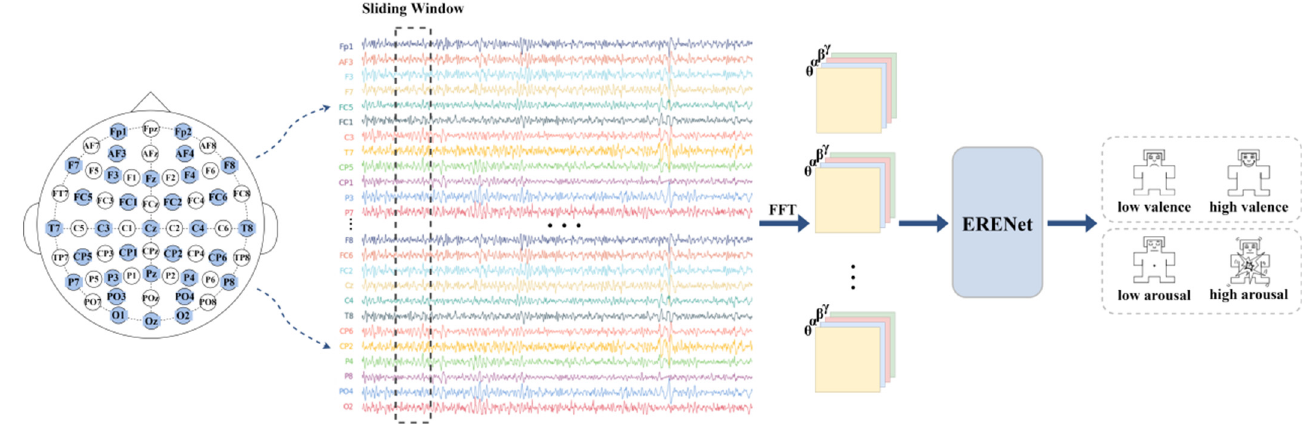
Figure 1. The emotion recognition framework from multi ‐ band EEG topology maps using ERENet.